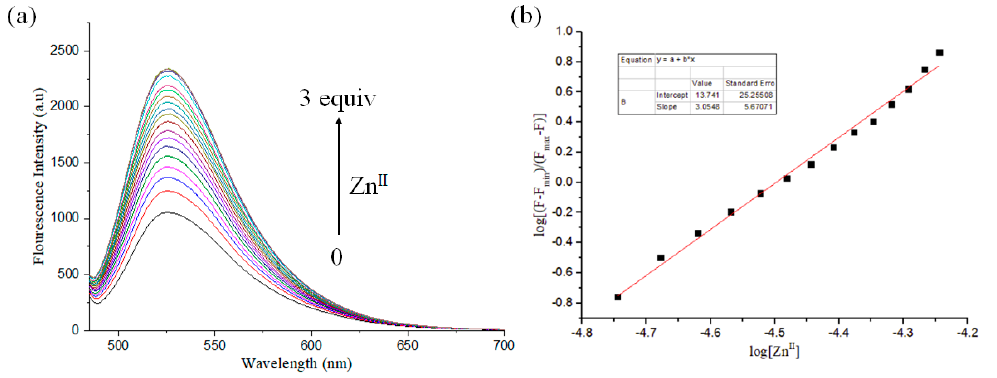
Figure 8. ( a ) Fluorescence spectrum changes of the H 4 L solution (c = 5 × 10 − 5 mol/L) upon addition of different amounts of Zn II ions (0–3.0 equiv) in dilute dichloromethane:methanol ( v : v = 1:1) solutions at room temperature; ( b ) The linear relationship between fluorescence intensity and the concentrations of Zn II ions. ( λ ex = 380 nm, λ em = 523 nm).